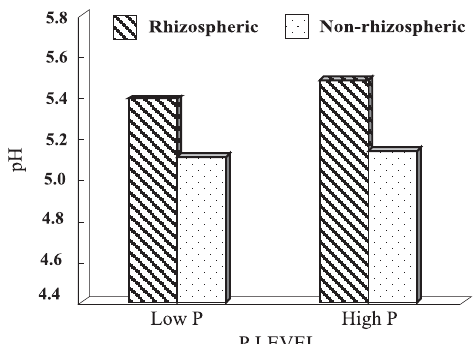
Figure 3. Mean pH values of rhizospheric and non- rhizospheric soil of maize genotypes grown at low and high P levels.